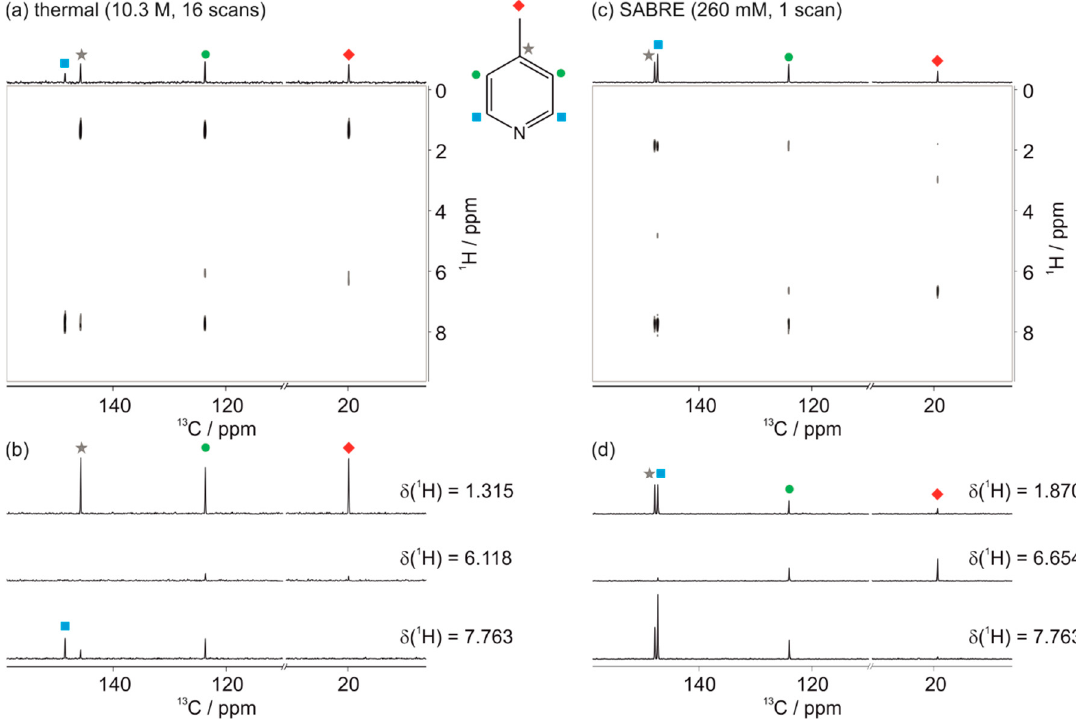
Figure 5. 2D 13 C– 1 H HETCOR benchtop NMR spectra of 4-methylpyridine (4-MP). ( a ) Thermally polarised spectrum of neat 4-MP (10.3 M) acquired with 64 steps each with 16 scans in a total experiment time of 307 min (5.1 h). ( b ) 1D slices through the 2D spectrum in ( a ) at the chemical shift of the methyl proton resonance (top), meta proton resonance (middle), and ortho proton resonance (bottom). ( c ) SABRE-hyperpolarised 2D spectrum of 260 mM 4-MP with 5.2 mM active SABRE catalyst in methanol- d 4 acquired with 90 steps each with a single scan in a total experiment time of 69 min. ( d ) 1D slices through the 2D spectrum in ( c ) as in ( b ). Note, the differences in chemical shifts between the two spectra are due to the presence of the solvent (methanol- d 4 ) in the SABRE case.